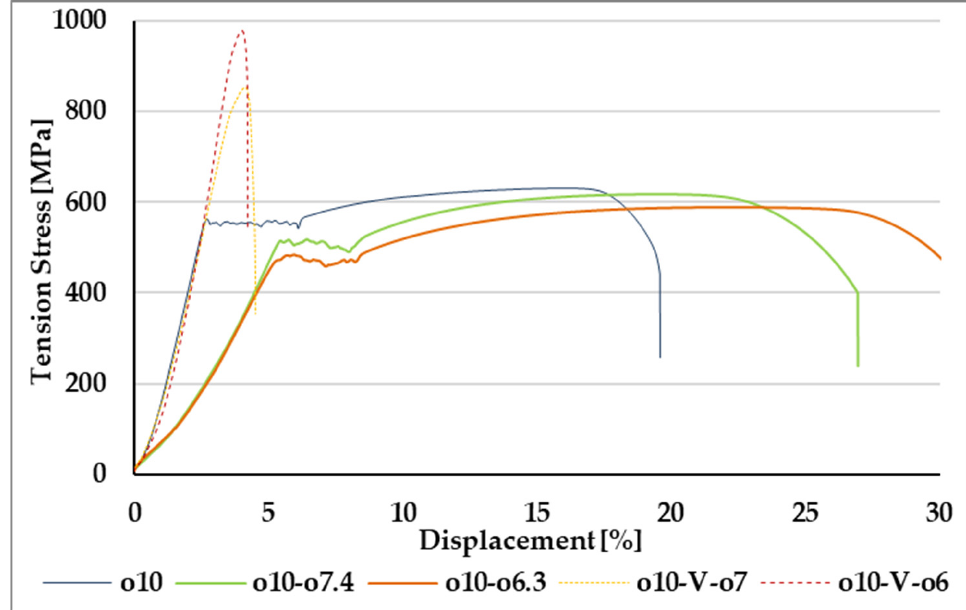
Figure 21. Dependence of stresses and deformations due to different depth of notch—reinforcement ϕ 10 B500 B.